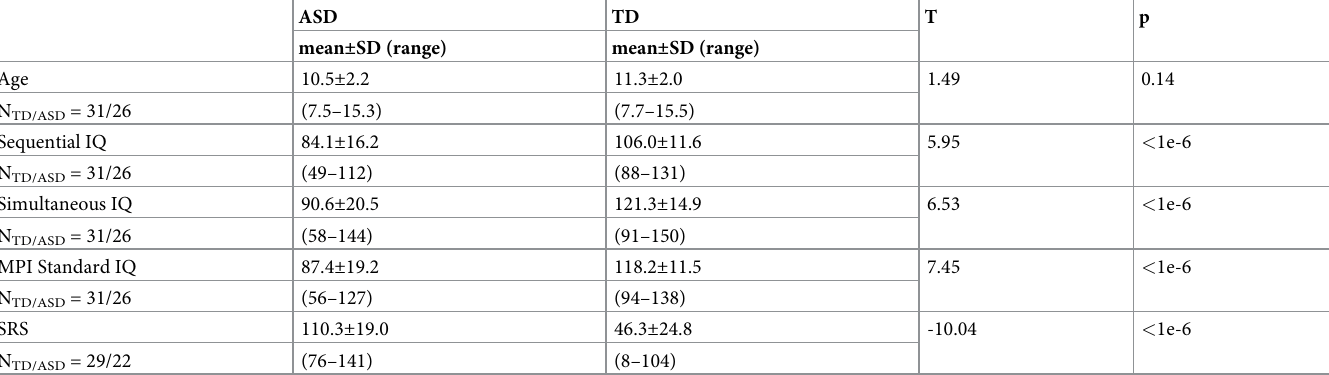
Table 2. Characteristics of the pediatric samples included in the analysis of correlations between MEG and psychophysical